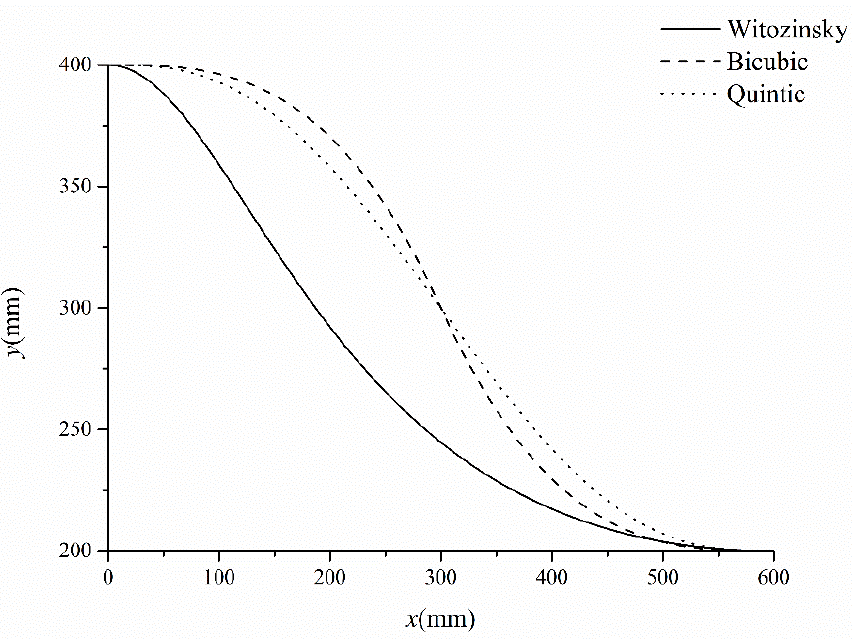
Figure 7. Alternative contraction curves of the Mars wind tunnel.